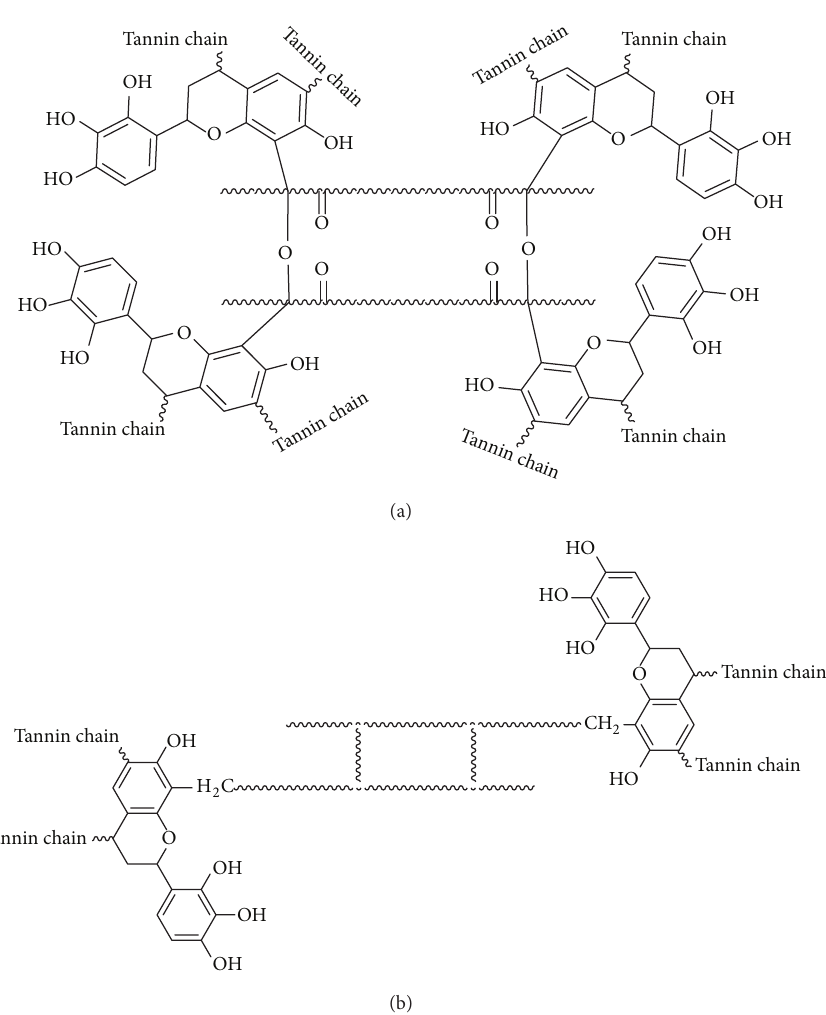
Figure 5: Proposed tannin-furanic interactions in formaldehyde-free TBRF (a) and classic TBRF